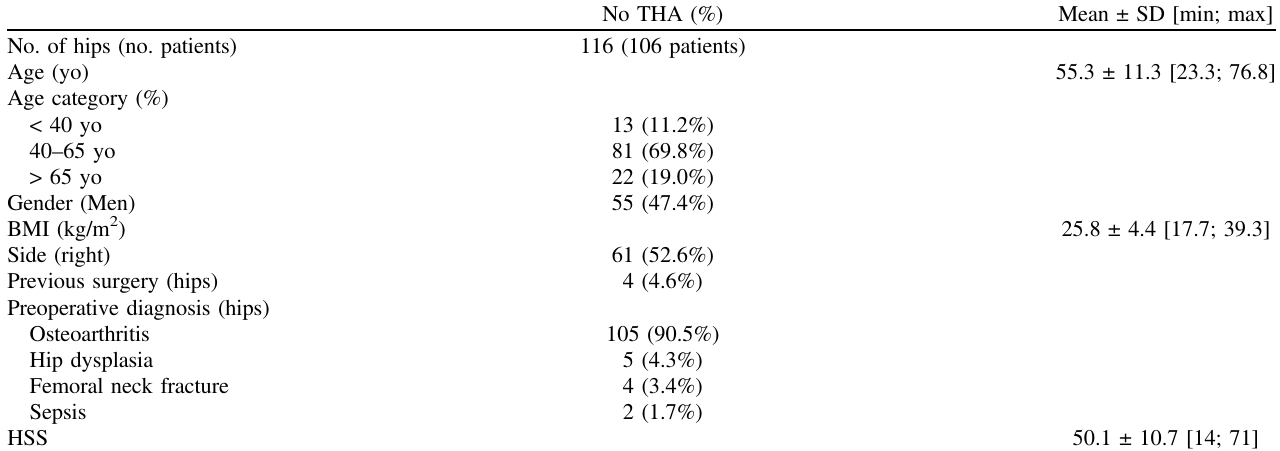
Table 1. Demographic characteristics and preoperative scores for THA.